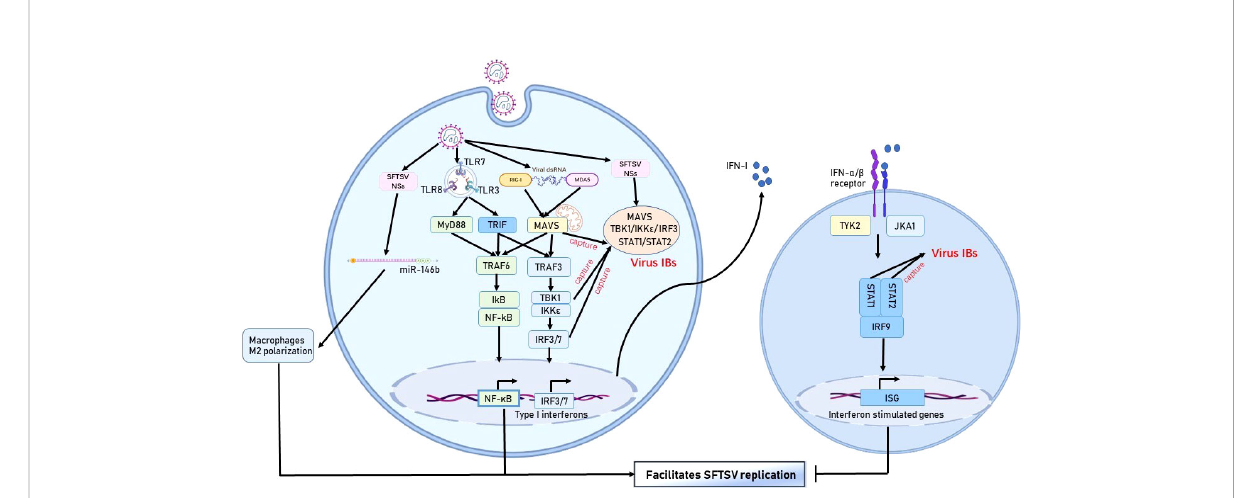
FIGURE 2 Immune escape mechanism of SFTSV in monocytes. The SFTSV NSs protein hijacks various protein molecules of the IFN pathway by forming IBs, thereby hindering IFN production. In addition, SFTSV activates the NF- k B pathway and promotes macrophage differentiation into the M2 phenotype to facilitate viral